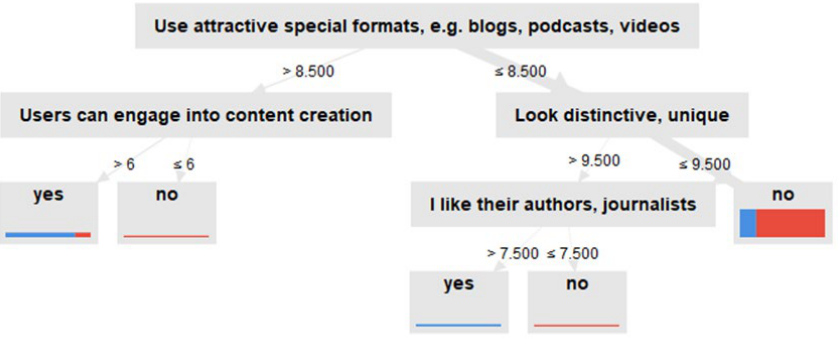
Figure 1. Delfi.lv brand uniqueness model. Decision tree, RapidMiner .